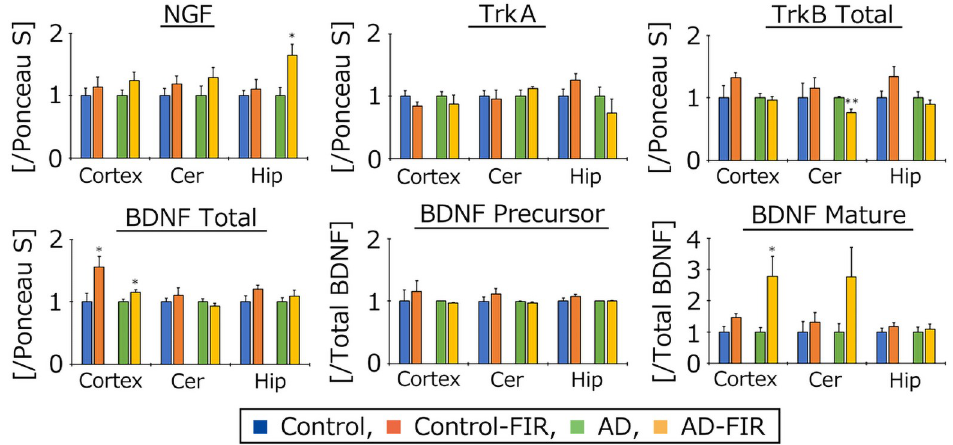
Fig 5. Western blotting analysis of the levels of each protein. Images of western blots for each protein examined in cortex (Cortex), cerebellum (Cer), and hippocampus (Hip) were scanned and digitized to determine band intensities, which were normalized to the intensity of staining by Ponceau S for the respective sample. Data are expressed as means ± SE (Control, n = 5; Control-FIR, n = 5; AD, n = 6; AD-FIR, n = 6). The data were analyzed using Tukey- Kramer’s tests. N.S., not significant (p � 0.05). � p < 0.05, �� p < 0.01 vs.